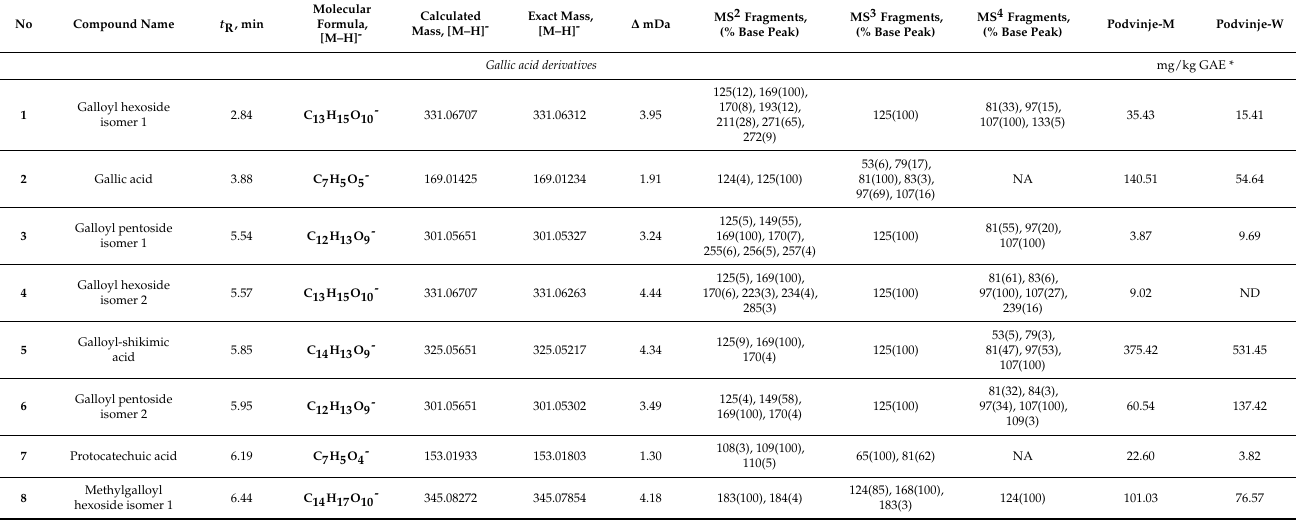
Figure 5. ( A ) Bioautography in situ—chromatograms of water (W) and methanolic (M) E. cicutar- ium extracts from the Podvinje locality (applied in triplicate) covered with inoculated MHA with S. aureus ATCC 6538 (1.5 × 10 6 CFU/mL) and stained with bacterial viability indicator TTC (1%, m/V). Zones of bacterial growth inhibition are yellow, while the parts with viable bacteria are in red. ( B ) Chromatograms of water (W) and methanolic (M) E. cicutarium extracts of from the Podvinje locality (applied in triplicate) on TLC silica gel F 254 plates, developed with mobile phase acetoni- trile/water/formic acid = 30:8:2 ( v / v / v ), and visualized with NSR (1%, m/V) at 366 nm. ( C ) Same chromatograms at 254 nm. Table 5. Phenolic composition of antimicrobially active fractions of E. cicutarium water (Podvinje-W) and methanolic (Podvinje-M) extracts from the Podvinje locality, isolated semi-preparatively based on bioautography with MSSA ATCC 6538, and analyzed via UHPLC-LTQ OrbiTrap MS 4 in negative ionization